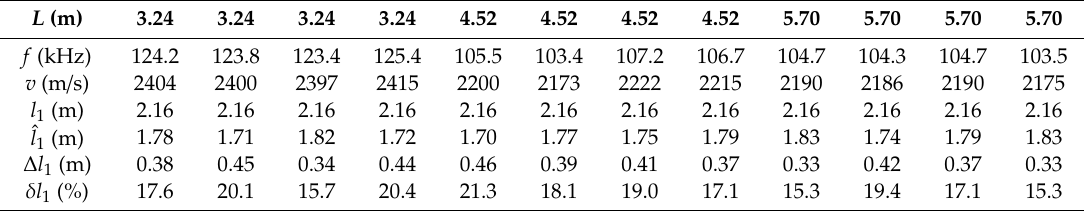
Table 2. The location results obtained by the CCF location method.